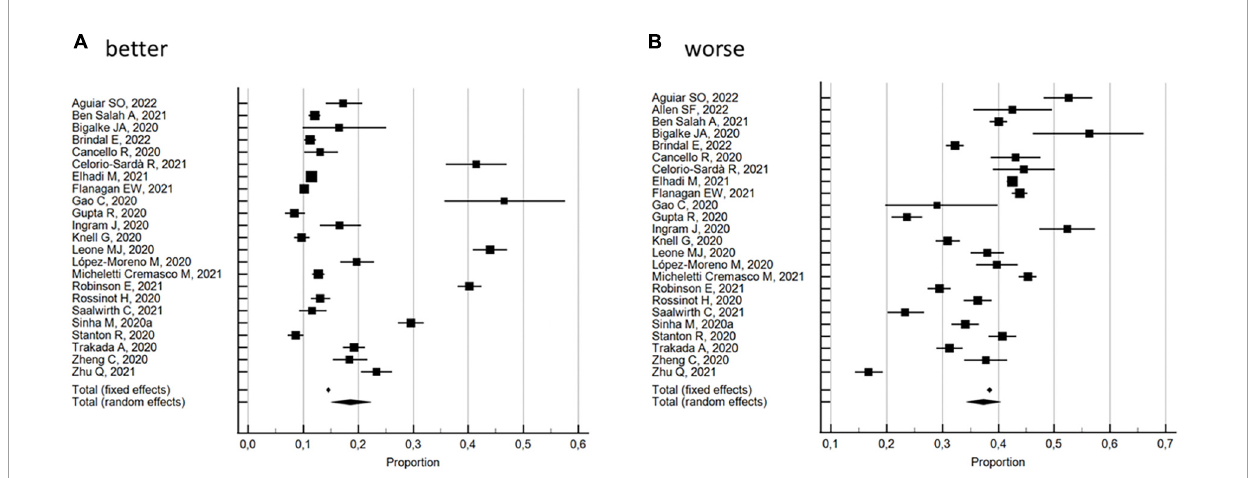
FIGURE4 Forest plot showing pooled percentages changes in sleep quality from before to during the COVID-19 lockdown: better (A) , worse (B) . Error bars = 95% confidence interval; Square boxes = individual point estimates; and Diamond box = pooled point estimates.